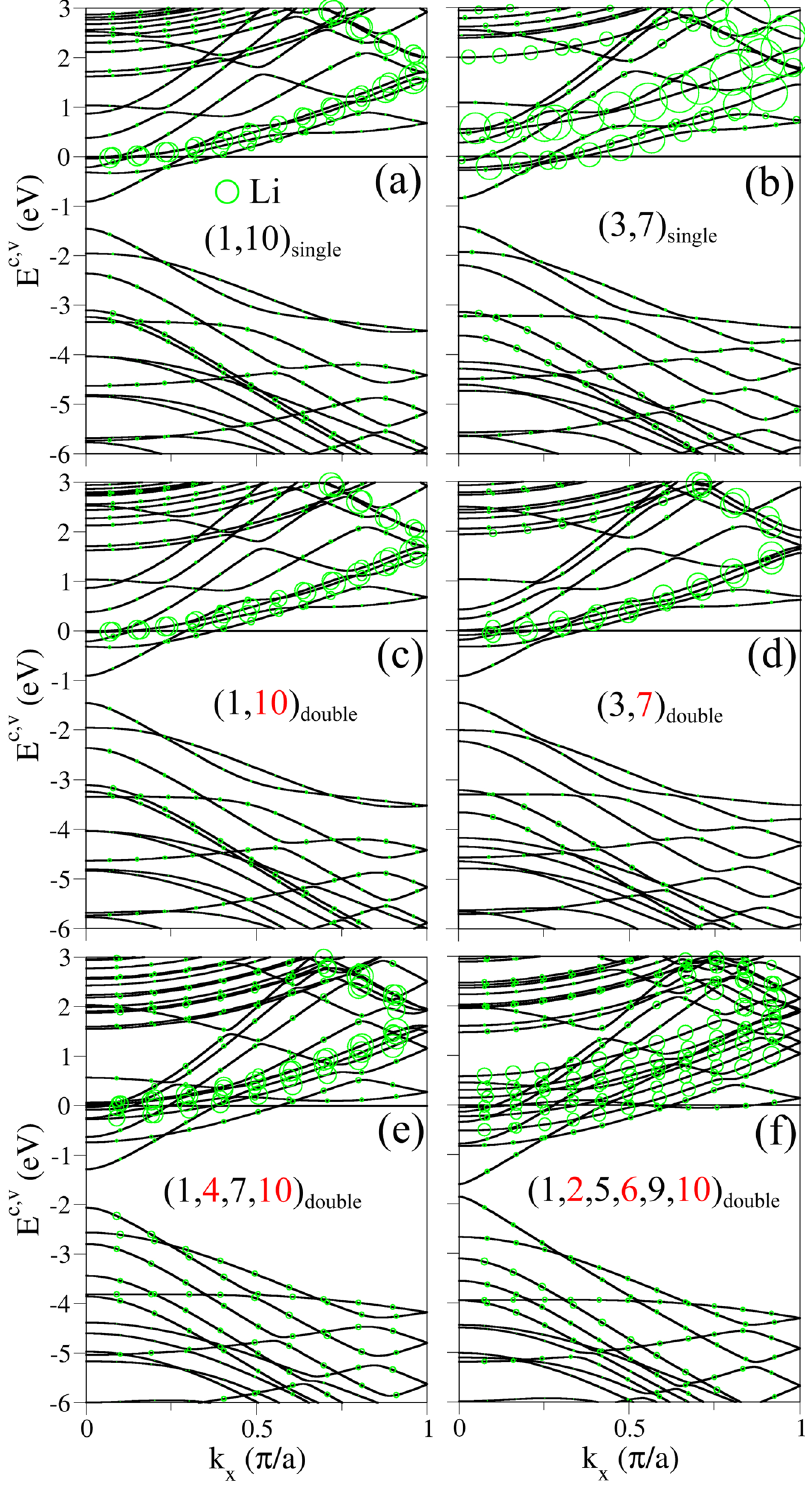
Figure 3. Similar plot as Fig. 2, but shown for the Li-adsorbed GNRs. ( a , b ), respectively, correspond to the single-side adsorptions of adatoms at (1, 10) single and (3, 7) single . The double-side adsorptions are shown for two adtoms at ( c ) (1, 10) double & ( d ) (3, 7) double , four adatoms at (1, 4, 7, 10) double , and six adatoms at (1, 2, 5, 6, 9, 10) double . Numbers correspond to the adatom adsorption position. Two colors (black & red) denote two distinct